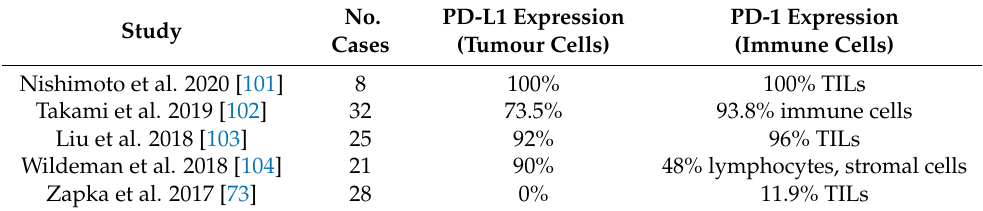
Table 7. Germinoma immune